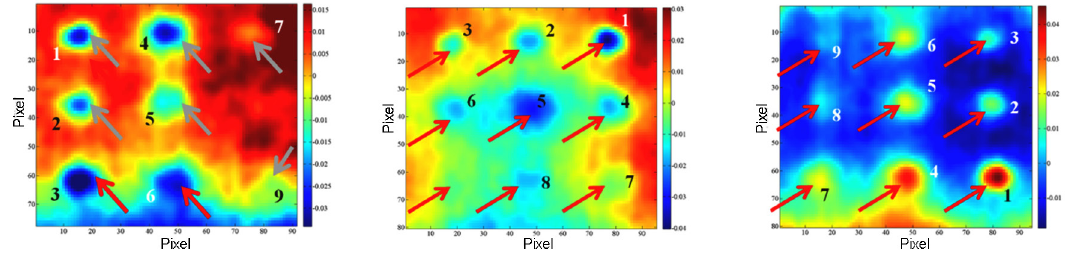
Fig. 12. PCT (EOF 2 ), BM 1-2, top surface, distance 2 m